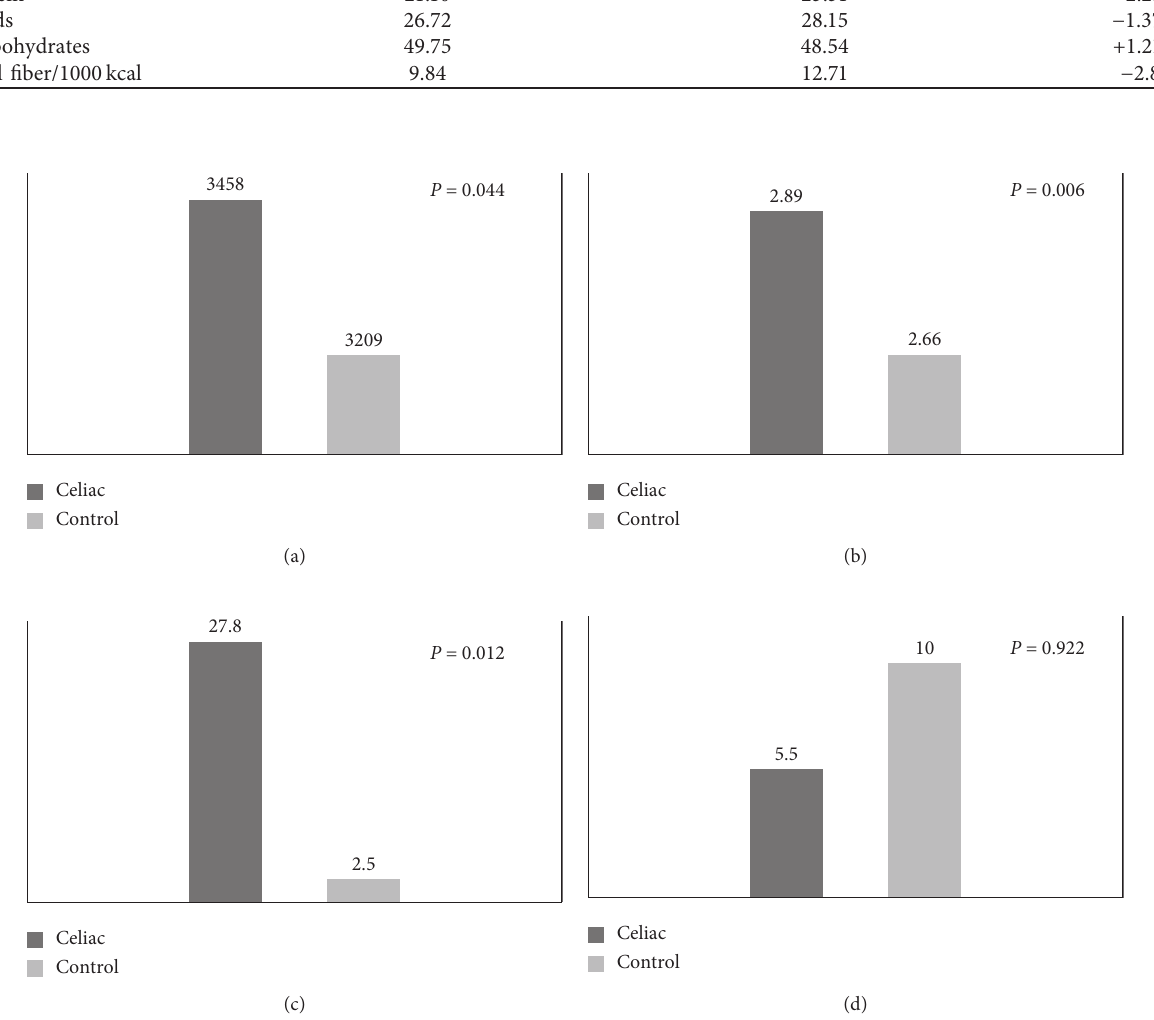
Figure 1: (a) Birth weight (grams). (b) Ponderal index (g/cm 3 ). (c) LGA (%). (d) SGA